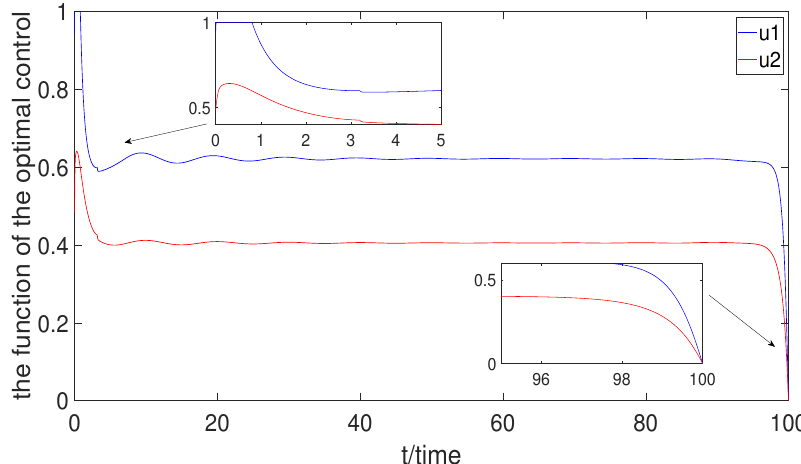
Figure 8. The optimal control curves when τ = 3.2.